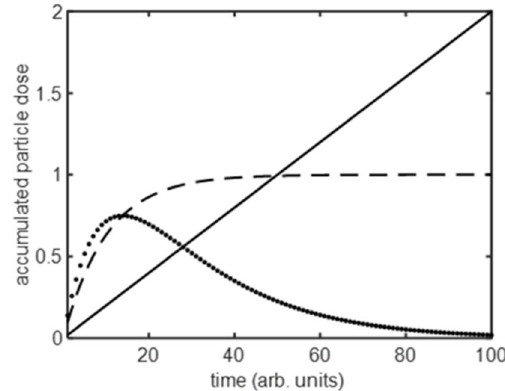
Figure 2. Schematic of the time-dependent cellular dose of nanoparticles under different conditions; i. accumulation at a constant rate from an infinite particle reservoir (solid line); ii. accumulation with a supply rate limitation or particle loss from the cell (dashed line); iii. accumulation with supply rate limitation and particle loss from the cell (dotted line).